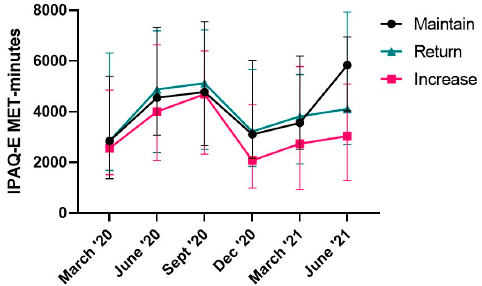
Figure 2. The influence of COVID-19 measures in the United Kingdom on the physical activity of individuals grouped by intended physical activity behaviour. (March ‘20 represents Pre COVID-19 restrictions; Data presented as Median and interquartile range; Maintain n = 29; Return n = 29; In- crease n = 38). 3.2. Perceived Barriers to Intended PA Target Behaviour The frequency of reported opportunity barriers to the intended PA behaviour was lower than barriers associated with capability and motivation (Figure 3. X 2 (2, n = 571) = 28.595; p < 0.001; V = 0.224). Physical capability barriers were more frequently reported (Figure 3. X 2 (1, n = 229) = 6.642; p = 0.010; V = 0.170), where ‘physical stamina’ and ‘physical strength’ were most common (Figure 3. X 2 (3, n = 134) = 20.209; p < 0.001; V = 0.388). There were no differences in the frequency of specific psychological capability barriers (Figure 3. X 2 (5, n = 95) = 5.863; p = 0.320; V = 0.248). Physical opportunity barriers were more frequently reported (Figure 3. X 2 (1, N = 131) = 32.252; p < 0.001; V = 0.496), where ‘more time’ and ‘triggers to prompt me’ were most common (Figure 3. X 2 (4, n = 98) = 44.347; p < 0.001; V = 0.673). There was no difference in the frequency of specific social opportunity barriers (Figure 3. X 2 (1, n = 33) = 44.347; p = 0.862; V = 0.095). There was no difference between the frequency of reported reflective and automatic motivation barriers (Figure 3. X 2 (1, n = 211) = 1.711; p = 0.191; V = 0.090). ‘Care about con- sequences of not doing it’ was more frequently reported than the other reflective motiva- tion barriers (Figure 3. X 2 (2, n = 115) = 8.470, p = 0.014; V = 0.271) and there was no differ- ence in the frequency of reported automatic motivation barriers (Figure 3. X 2 (1, n = 96) = 1.042; p = 0.307; V = 0.104).